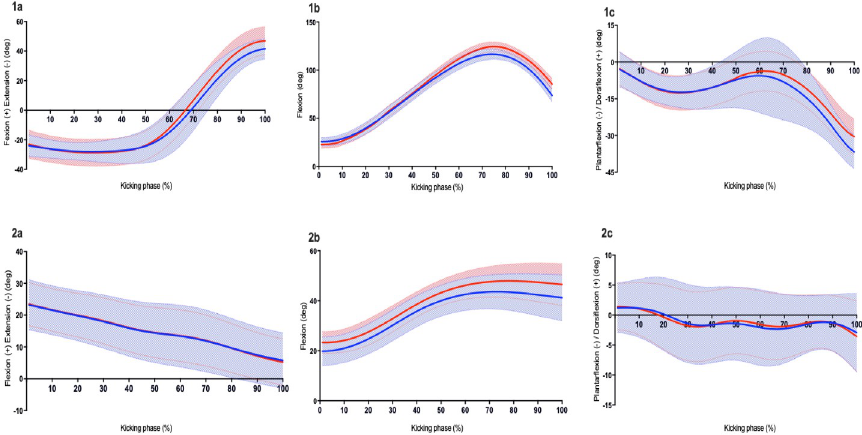
Fig 3. Group mean ± SD for sagittal hip (a), knee (b) and ankle (c) joint angles curves of the kick-leg (1) and support-leg (2) for accurate (blue line) and inaccurate (red line) goal-kicks during the kicking phase (kick leg toe- off: 0%, to BC: